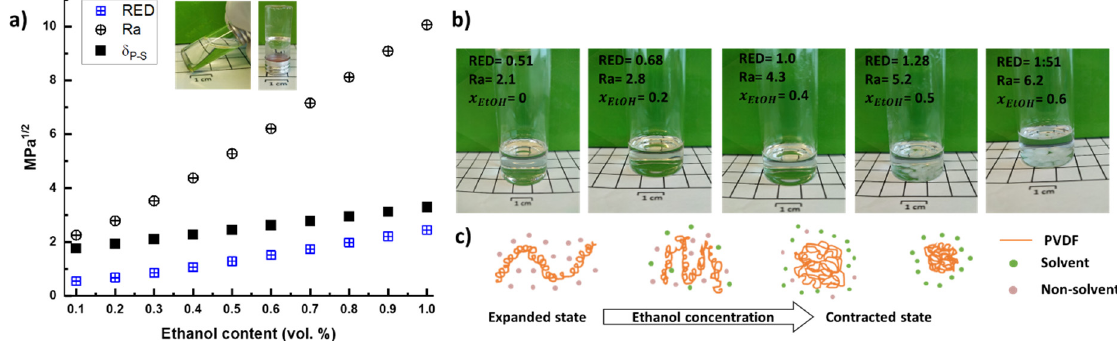
Figure 2. ( a ) RED values at different solvent compositions (blue crossed squares), the distance between the polymer and the solvent coordinates in a three-dimensional Hansen space (crossed circles), and difference of the solubility parameters, as a function of the ethanol content in the solvent mixture (filled squares); ( b ) PVDF dissolved at 80 °C in different solvent blends; ( c ) state of the polymer coils as a function of the ethanol content.